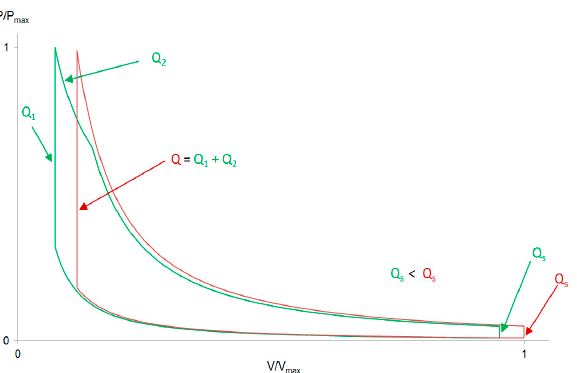
Figure 1. The energy concept of the new theoretical cycle. The proposed theoretical cycle, the green color is distinguished by an additional isothermal transformation, which is not taken into account at all in the theoretical analysis of the current internal combustion engines.